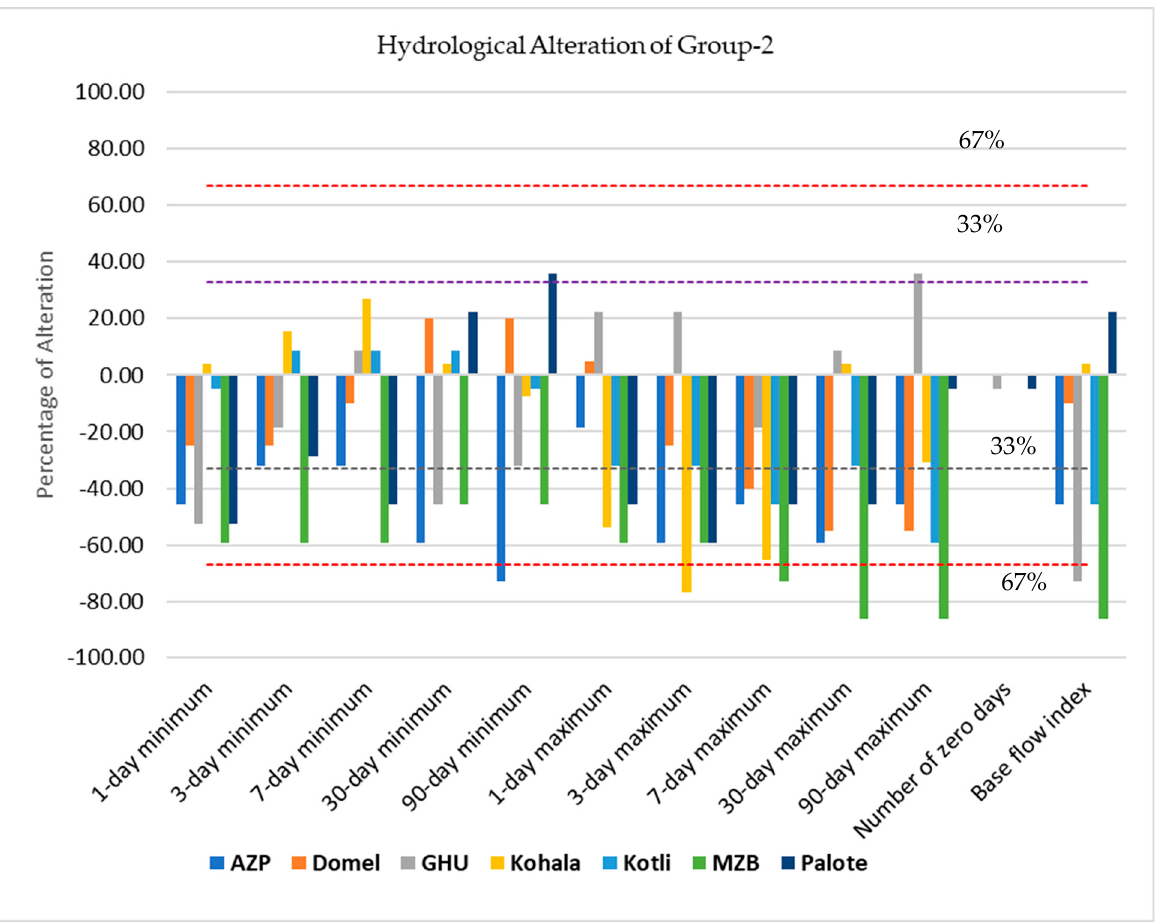
Figure 4. Hydrological Alteration of Group − 2 indicators.